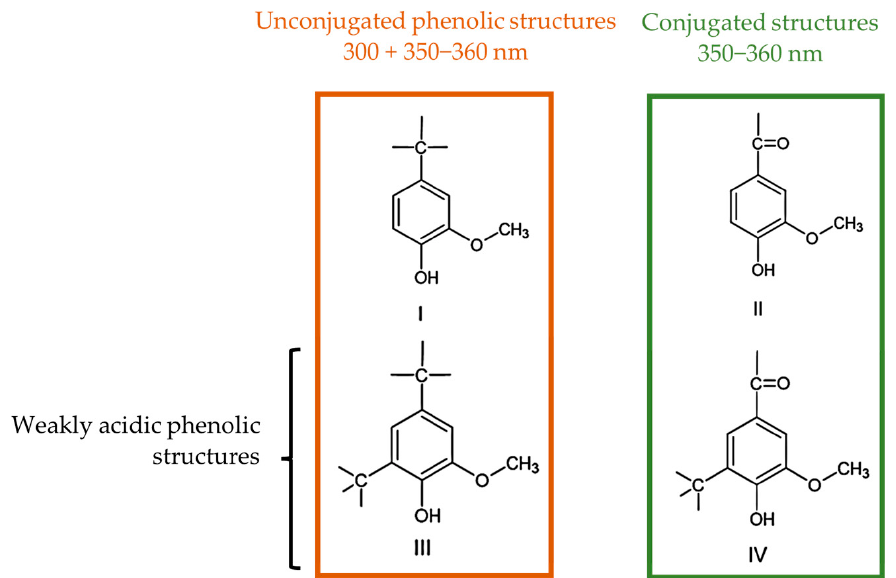
Figure 3. Phenolic structures identified by the UV method (adapted from [38,39]).